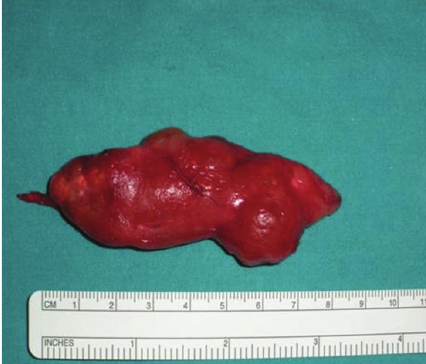
Figure 4: The gross appearance of the dissected cervical mass and the surrounding